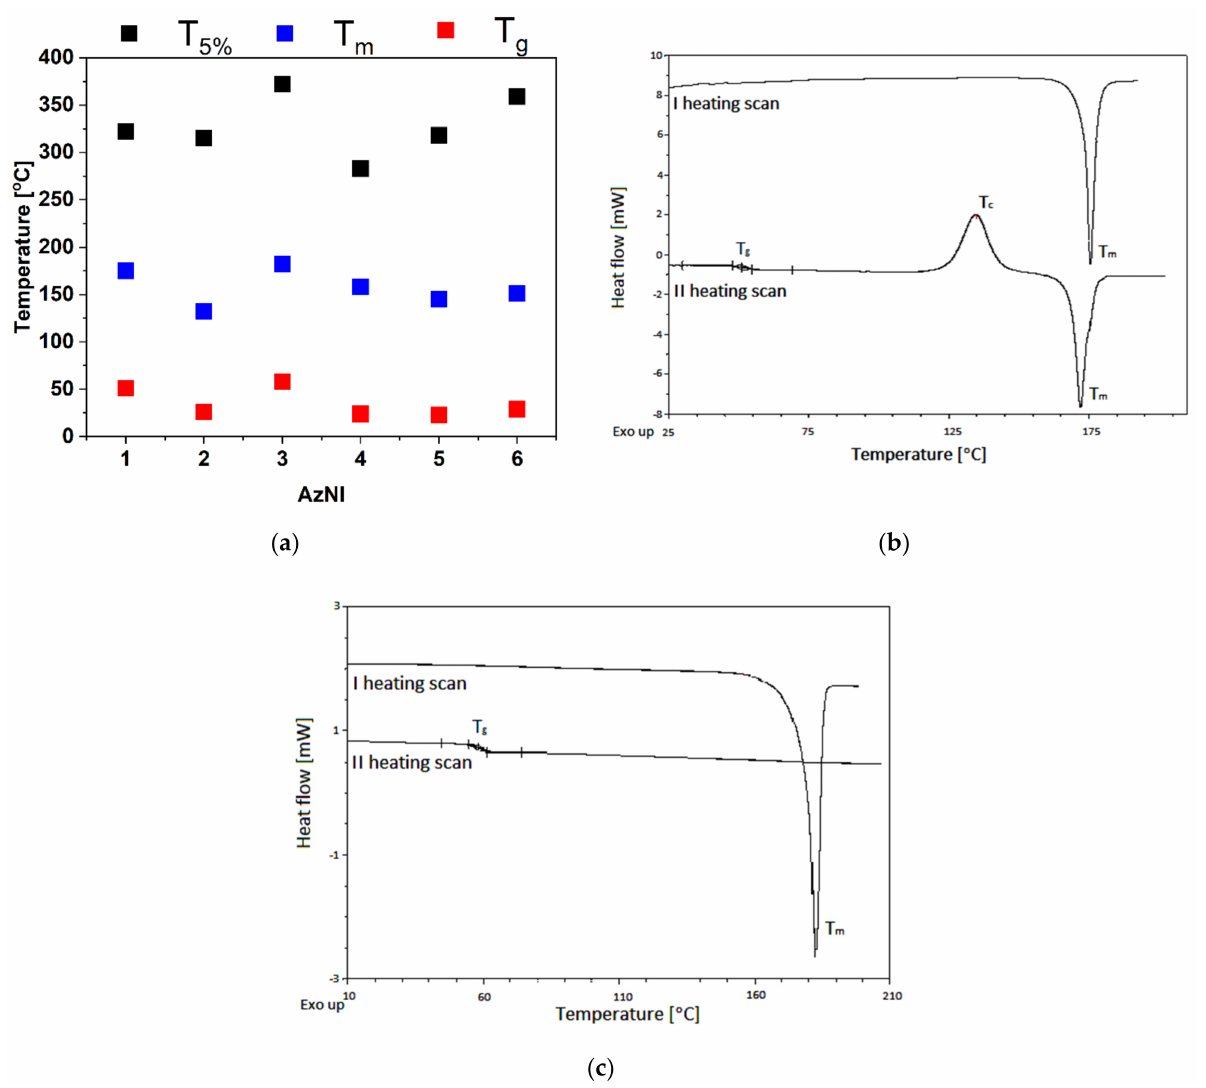
Figure 2. ( a ) Collected data from the DSC TGA investigations and ( b ) DSC thermograms of AzNI-1 and ( c )